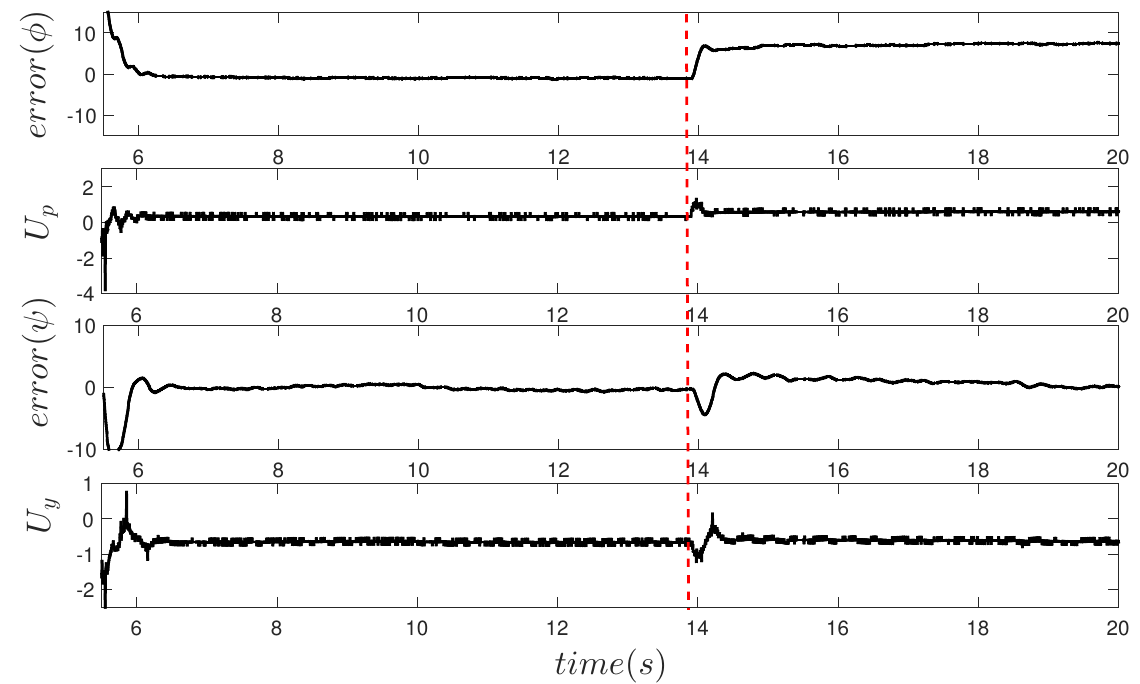
Figure 12. Response to the presence of failure in actuator f a 1 of